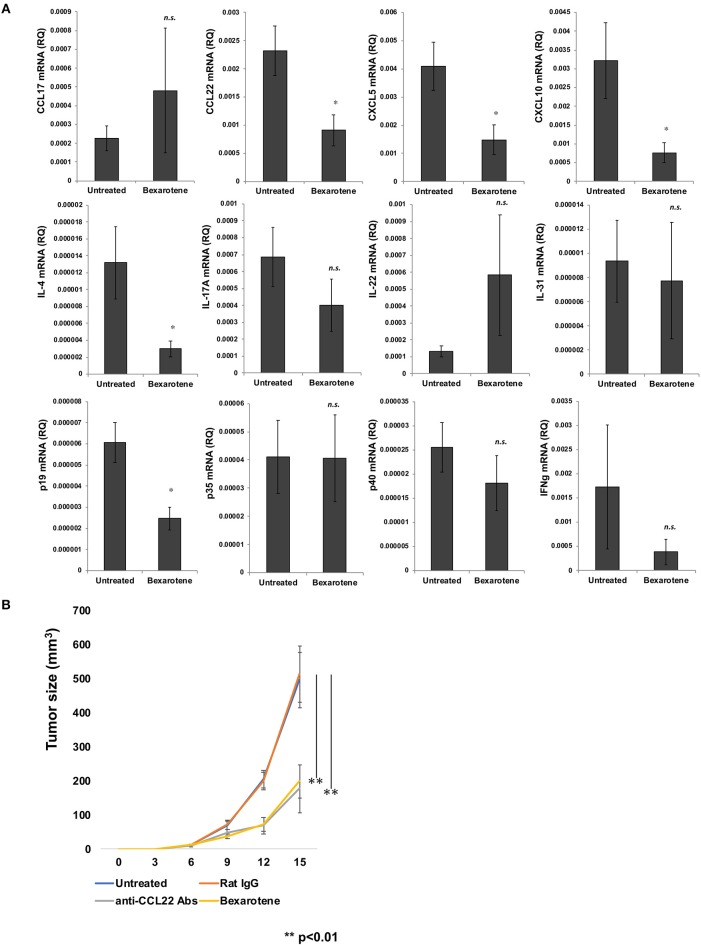
Intraperitoneally administered bexarotene modifies chemokine and cytokine expression in mouse EL4 T-cell lymphoma. Expression of chemokines and cytokines in EL4 T-cell lymphoma was analyzed by quantitative RT-PCR using the ΔCt method (n = 5). Averages of five independent experiments are shown (A). We subcutaneously injected 100 μl of 2 × 106 cells/ml of EL4 T-cell lymphoma cells, and intraperitoneally injected 0.15 mg bexarotene or 0.30 mg anti-CCL22 antibodies (R&D Systems, Minneapolis, MN) at day 6 and day 12 (n = 5 for each treated group) Error bar represents ± standard deviation. (B) One representative experiment of two is shown *p < 0.05, **p < 0.01. Error bar represents ± standard deviation.